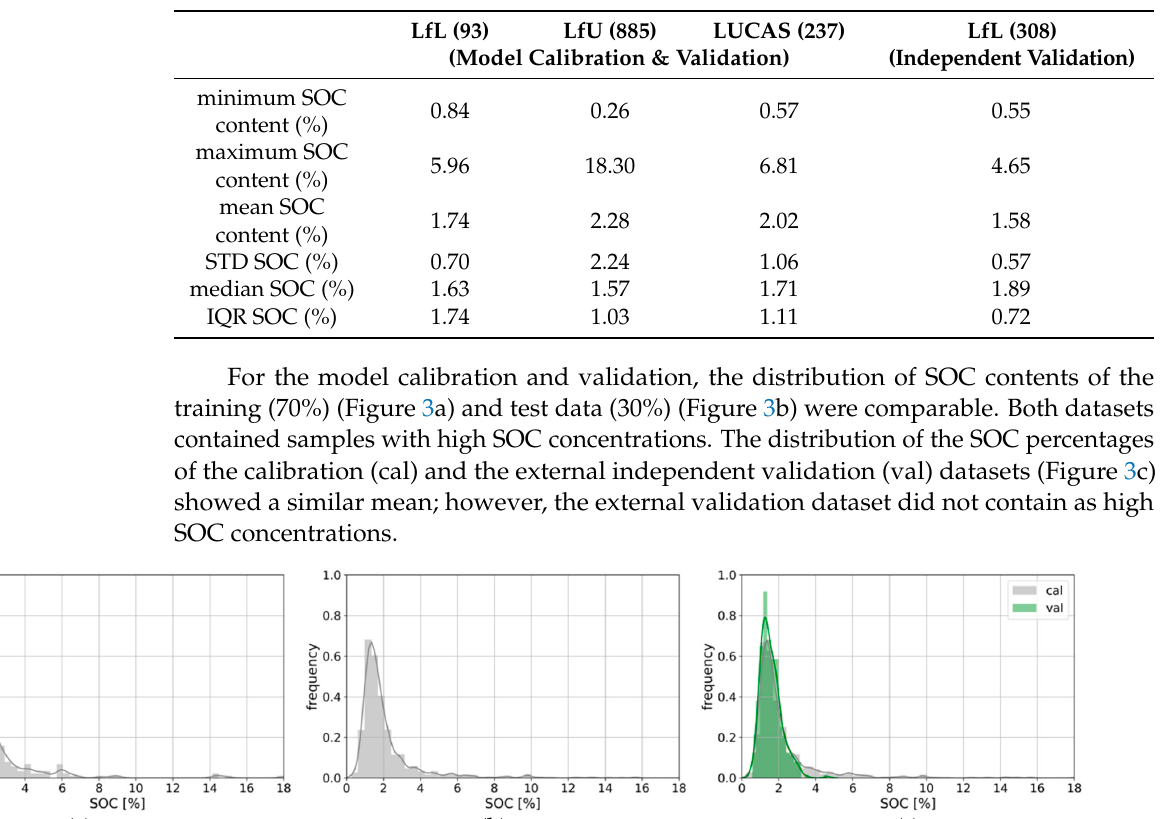
Table 3. Statistics of the soil organic carbon (SOC) content of the model calibration soil samples and the independent validation soil samples by the different institutions. The number of samples per institute is given based on the spatially/spectrally filtered culsters (LfU—Bavarian Environmental Agency; LfL—Bavarian State Research Center for Agriculture; LUCAS—Land Use/Cover Area Frame Statistical Survey; STD—Standard Deviation; IQR—Interquartile Range).